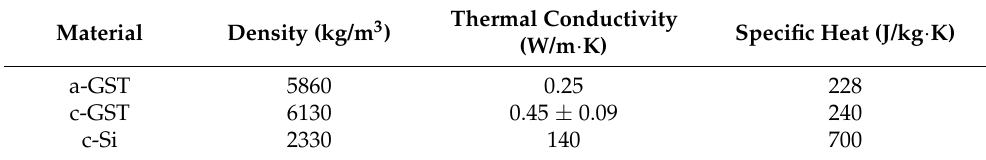
Table 1. The material properties of c-Si and